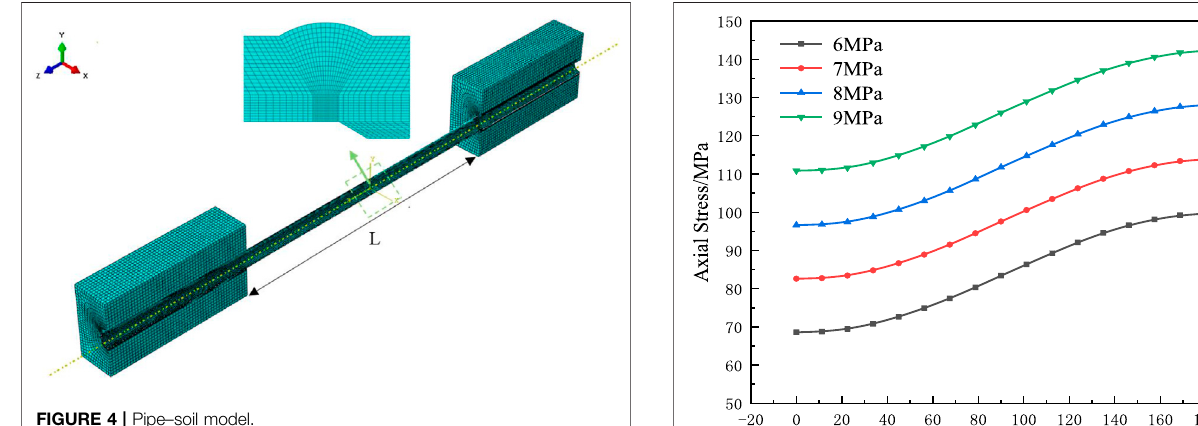
FIGURE 4 | Pipe – soil model.